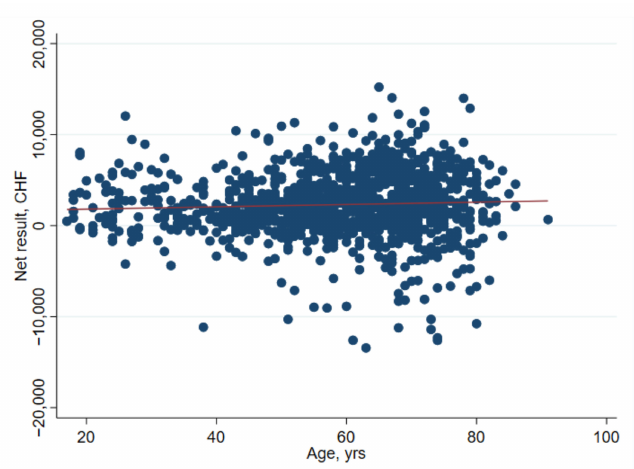
Figure 1. Correlation between age and net financial results. The red line indicates the fitted